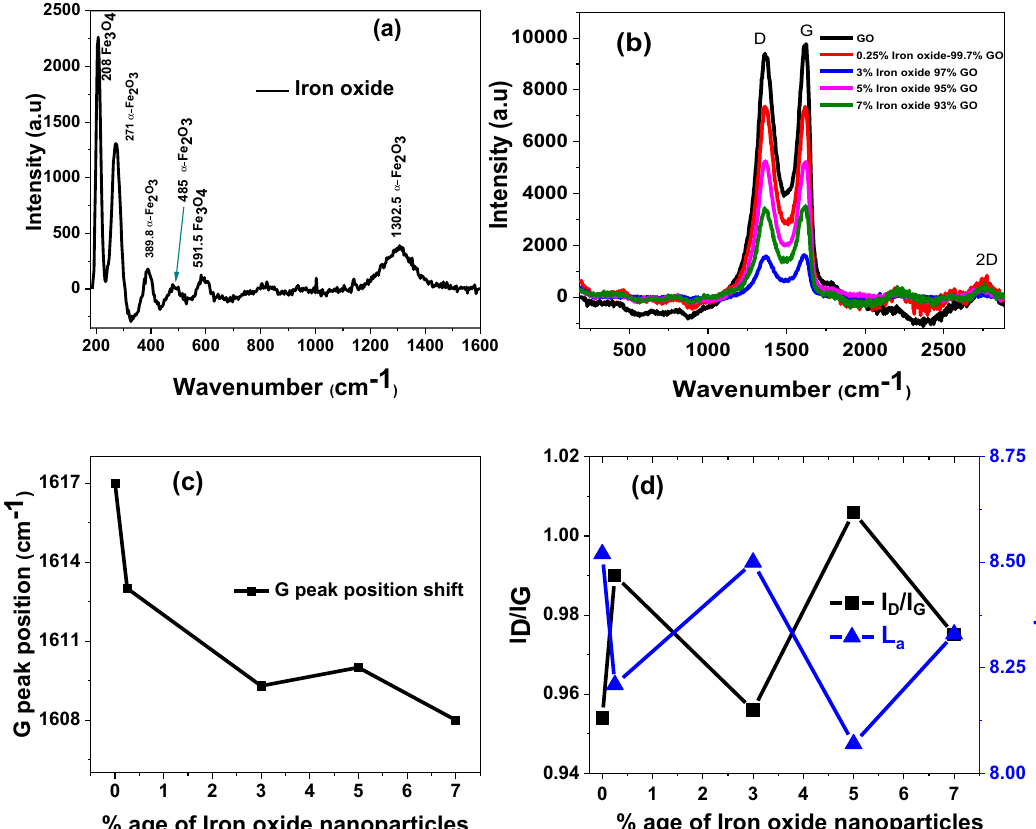
Figure 8. Raman spectra of ( a ) Iron oxide ( b ) nanocomposites samples ( c ) Raman peaks intensity ratio ( d ) G-peak position shift versus iron oxide concentration in nanocomposites series of